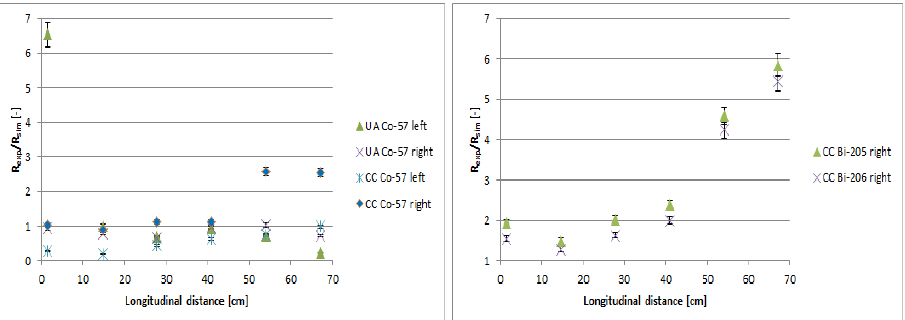
Figure 5. Experimental and simulated reaction rate ratios of 57 Co, 205 Bi and 206 Bi production for UA and CC experiments. Mean values are: <R exp /R sim >( 57 Co, UA, left) = 1.68(9), <R exp /R sim >( 57 Co, UA, right) = 0.85(4), <R exp /R sim >( 57 Co, CC, left) = 0.55(3), <R exp /R sim >( 57 Co, CC, right) = 1.54(8), <R exp / R sim >( 205 Bi, CC, right) = 3.05(14), <R exp /R sim >( 206 Bi, CC, right) =